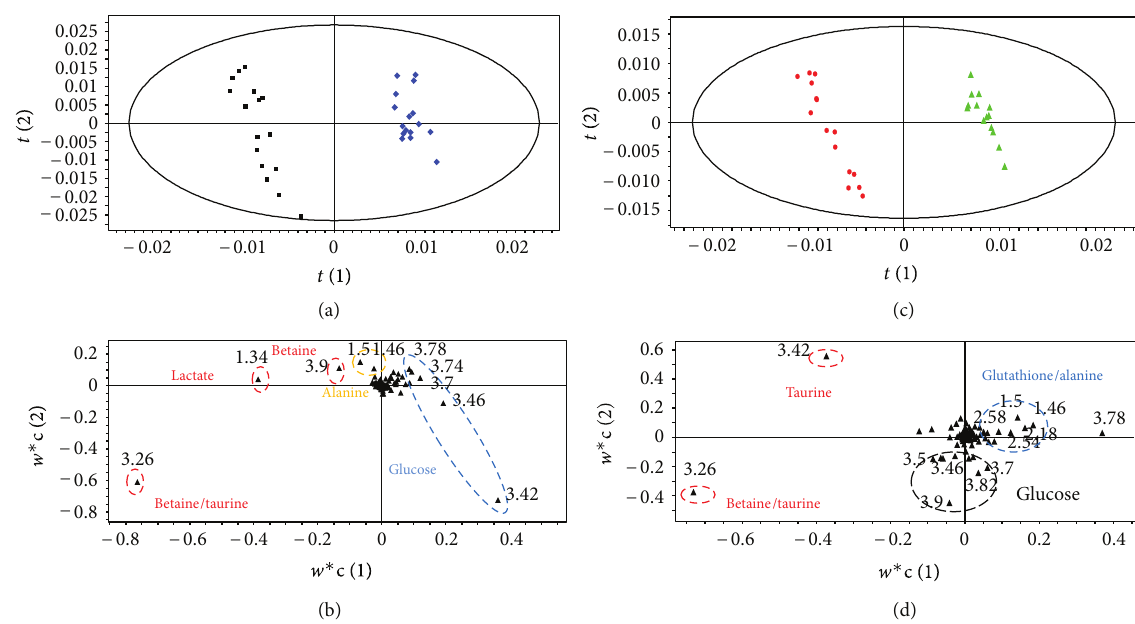
F 6: PLS-DA (a) score plot and (b) loading plot based on the HNMR spectra of aqueous liver extract samples from nonexposed